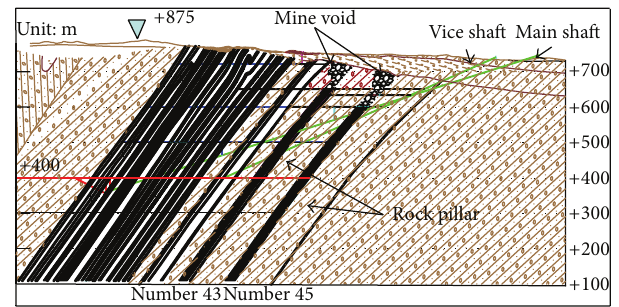
Figure 1: The existence of steep-heavy-thick coal seams in sectional